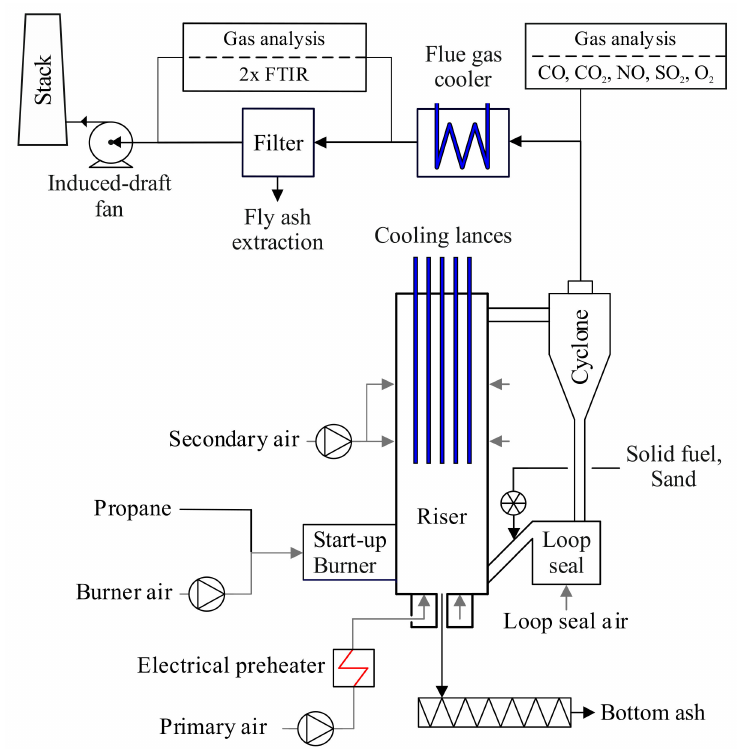
Figure 1. Simplified flow diagram of the 1 MW th pilot